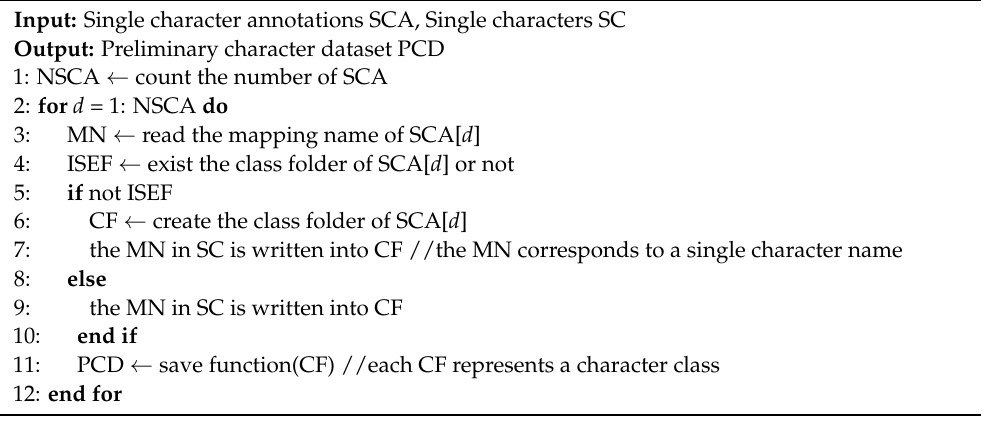
Algorithm 2: Construction of the algorithm of the character dataset based on real position sequence